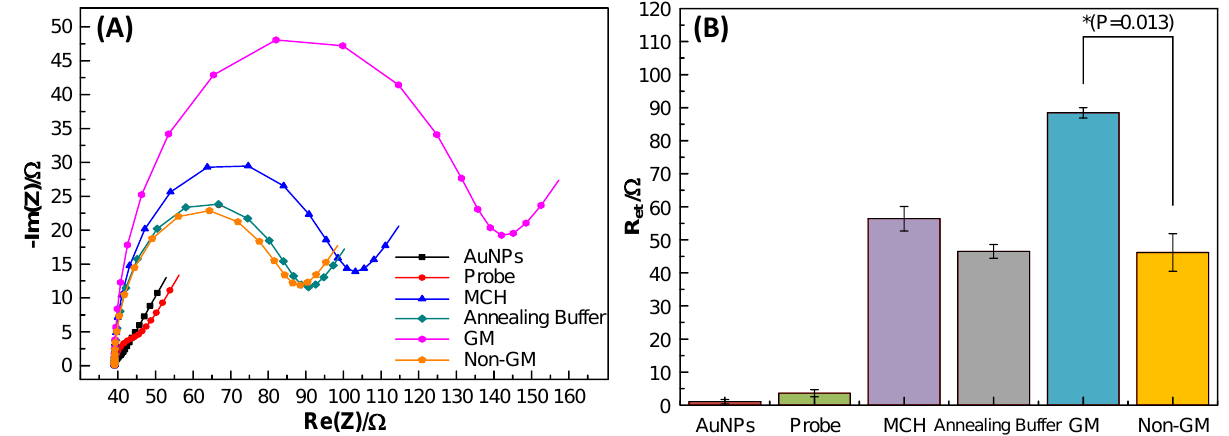
Figure 4. EIS results of each modification step on the electrode. ( A ) Nyquist plots (MCH = 5 mM, Target dsDNA = 20%), ( B ) bar graph of ( A ), N = 6. Student’s t -test statistics: significantly different (*): p < 0.05. (2) Calibration curve for GMS detection Different percentages, 1%, 3%, 5%, 5.7%, 6%, 10%, 20%, 40%, and 80% of the extracted GMS DNA were employed for the construction of the calibration curve for GMS detection. Figure 5A shows the percentage while Figure 5B shows the concentration calibration curves for GMS DNA detection. As shown in Figure 5A, two percentage calibration curves were obtained. The calibration curve corresponding to the lower percentage range (1 – 6%) exhibits a sensitivity of 2.36 Ω/% with R 2 = 0.9983, while the calibration curve correspond- ing to the higher percentage range (6 –40%) possesses a sensitivity of 0.1 Ω/% with R 2 = 0.9928. The Invitrogen Qubit 4 fluorometer an d the Qubit™ 1X dsDNA HS Assay Kit were used to convert the percentage of target DNA to concentration. The low percentage stand- ard curve (1%, 3%, 5%, and 6%) shown in Figure 5A was converted to the concentration standard curve, as shown in Figure 5B. The sensitivity and R 2 were 0.735 Ω/(ng/μL) and 0.995, respectively.